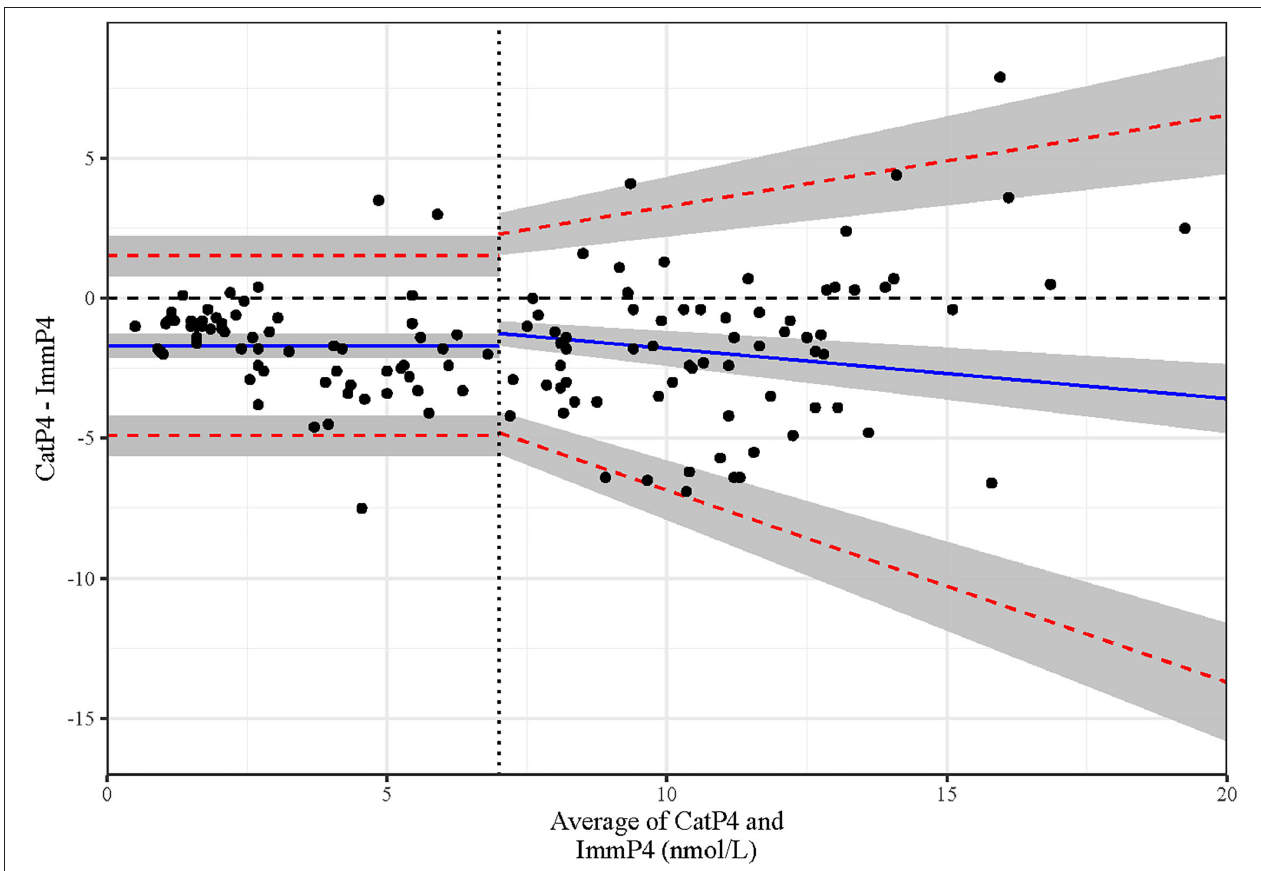
FIGURE 3 | Bland-Altman plot showing agreement between 134 progesterone levels measured with the point-of-care Catalyst assay and those measured with chemiluminescent immunoassay